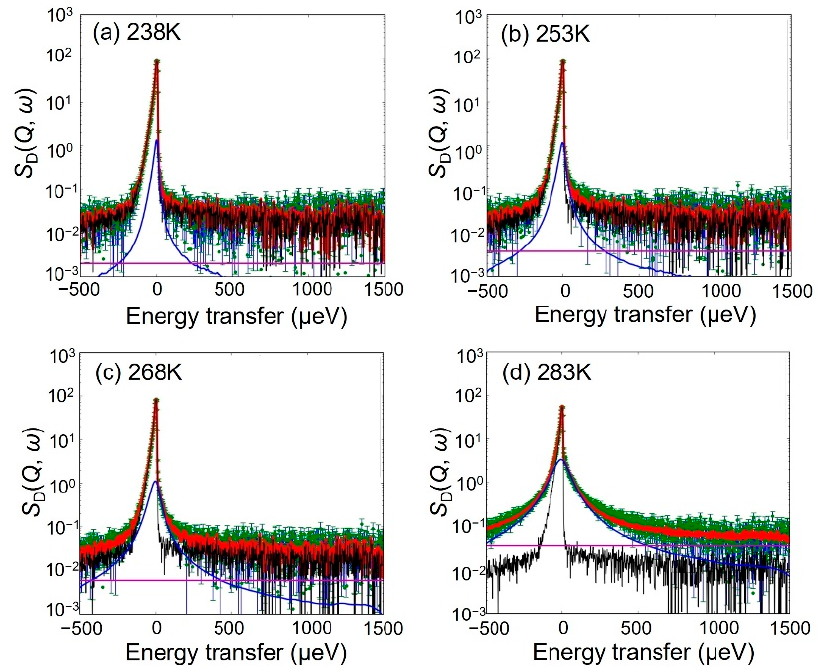
Figure 11. QENS spectra and fitted results of S D ( Q , ω ) with a resolution of 12 µeV at Q = 1.0 Å − 1 and at ( a ) 238 K, ( b ) 253 K, ( c ) 268 K, and ( d ) 283 K. The green points and red lines represent the observed intensities and the fitted curves. The black and blue lines represent the contributions from the delta and the Lorentz functions, respectively, which are convoluted by the resolution function. The magenta line represents the flat BG.